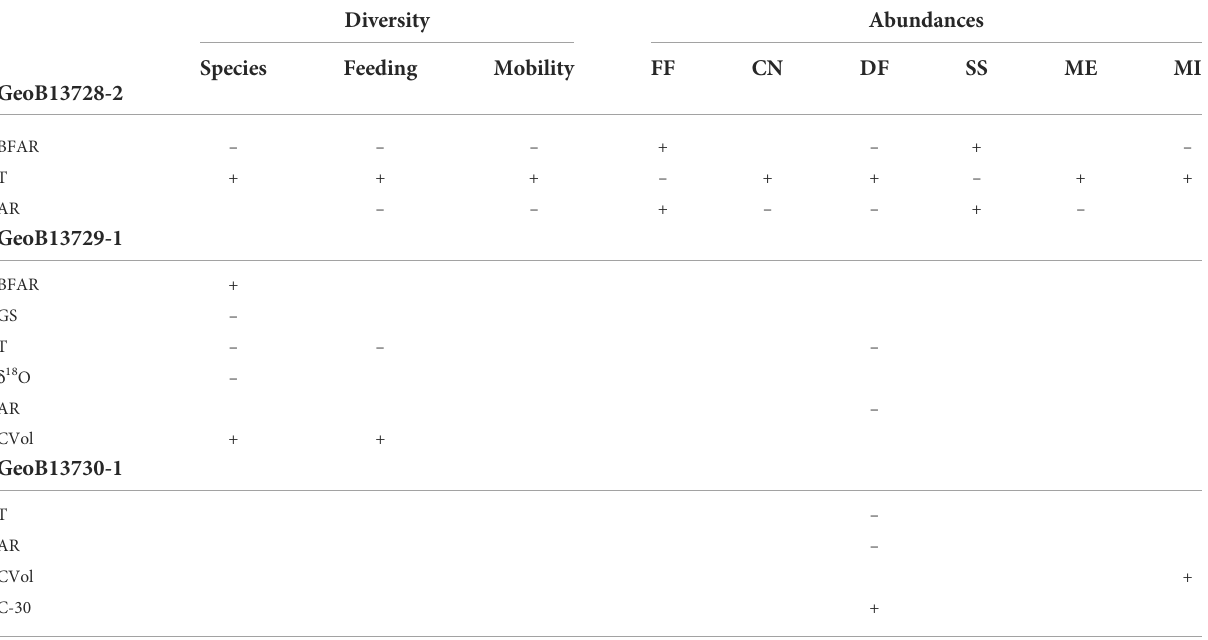
+ indicates a positive relationship. – indicates a negative relationship. See Table S8 for all rho coef fi cients and p-values. Molluscan traits: FF – fi lter feeder, CN – carnivore, DF – deposit feeder, SS – sessile, ME – mobile epifaunal, MI – mobile infaunal. Palaeoceanographic parameters (measured from the off-mound core GeoB13731-1): BFAR – benthic